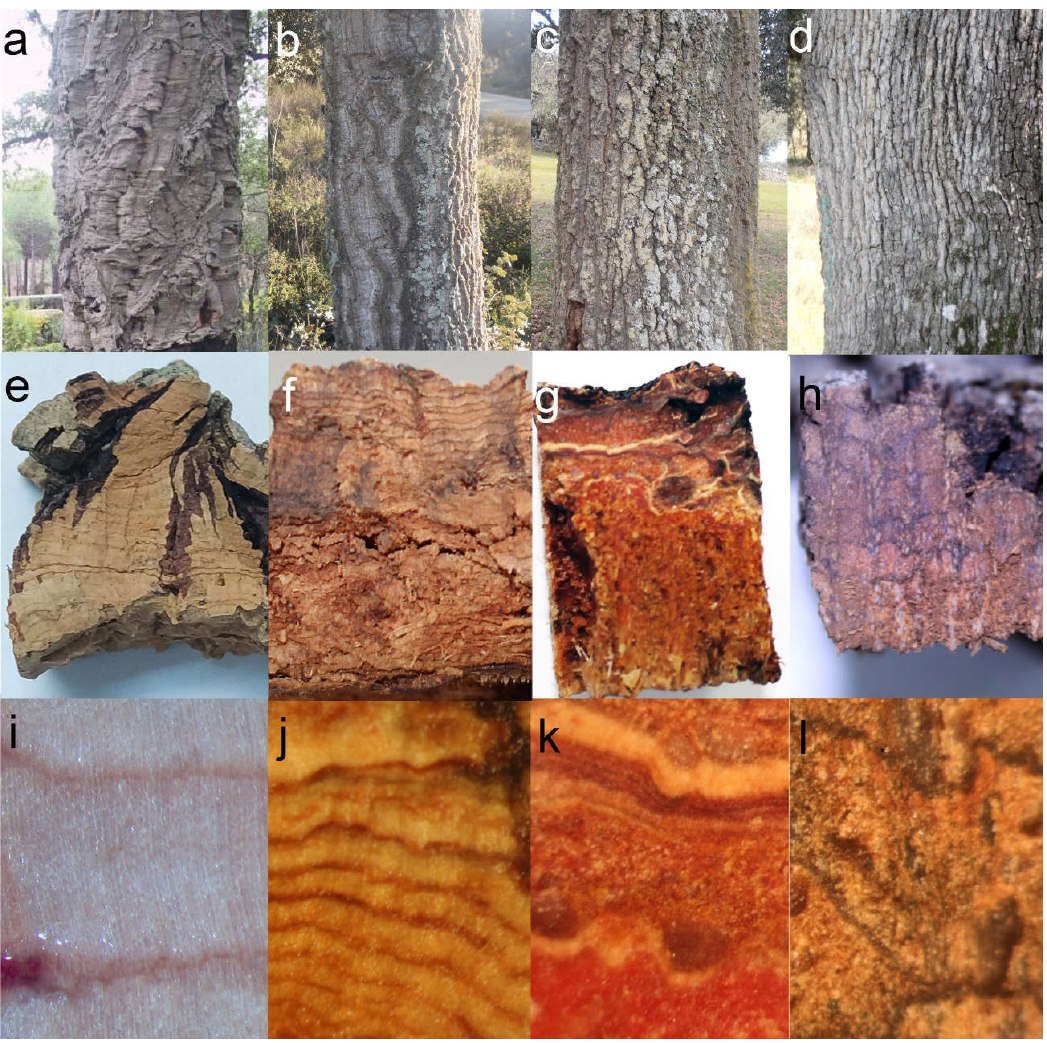
Figure 1. Barks of Q. suber ( a , e , i ), suber-like hybrid ( b , f , j ), ilex-like hybrid ( c , g , k ) and Q. ilex ssp. rotundifolia ( d , h , l ) as seen in the tree ( a – d ), and in transverse section, both de visu ( e – h ) and under magnifying glass ( i – l ).